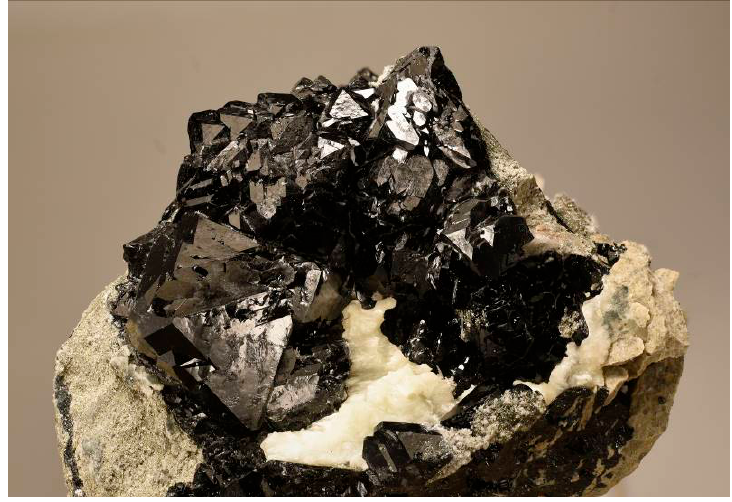
Figure 25. Voltaite from the Monte Arsiccio mine, as up to 2 cm-sized octahedral crystals.